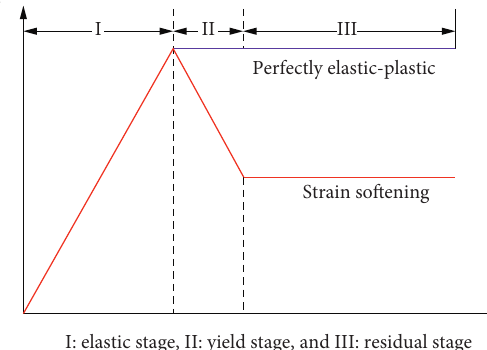
Figure 11: Softening model curve.